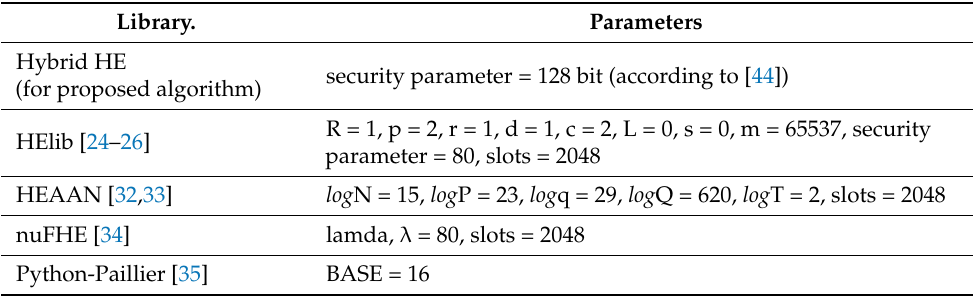
Table 3. Parameters used for each